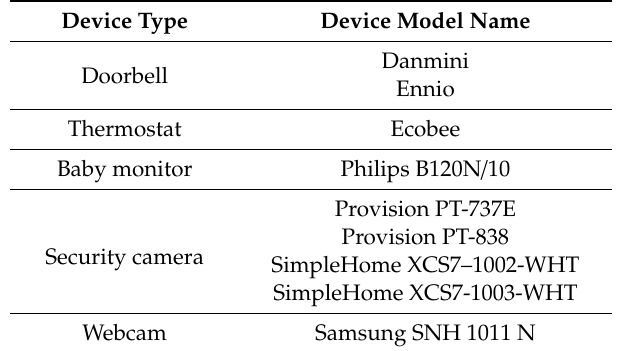
Table 5. Specific device type and model name in the N-BaIoT